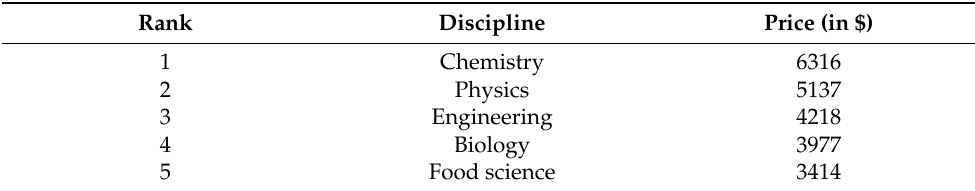
Table 4. Average journal price by discipline in 2020. Top five ranking. [Source: Library Journal Periodicals Price Survey,